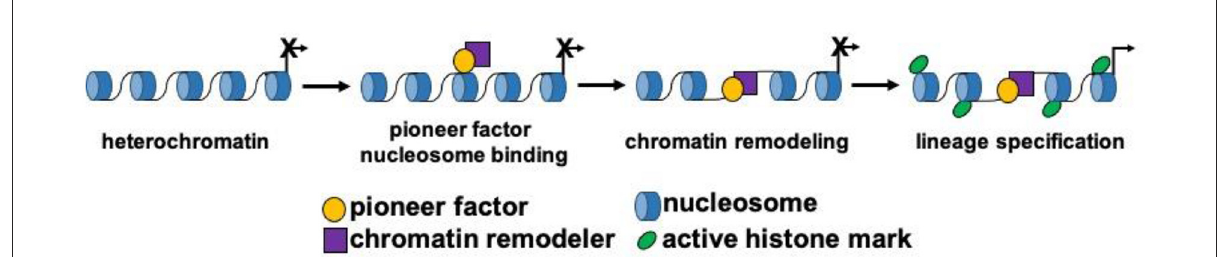
FIGURE1 Pioneer factors drive lineage specification. Schematic model depicting the function of pioneer transcription factors during cellular lineage specification. Pioneer factors initially bind to nucleosomal DNA and then remodel chromatin by themselves or by recruiting a chromatin